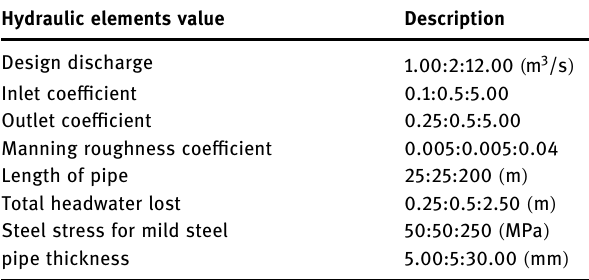
Table 1: Parameters used for designing and analysis Hydraulic elements